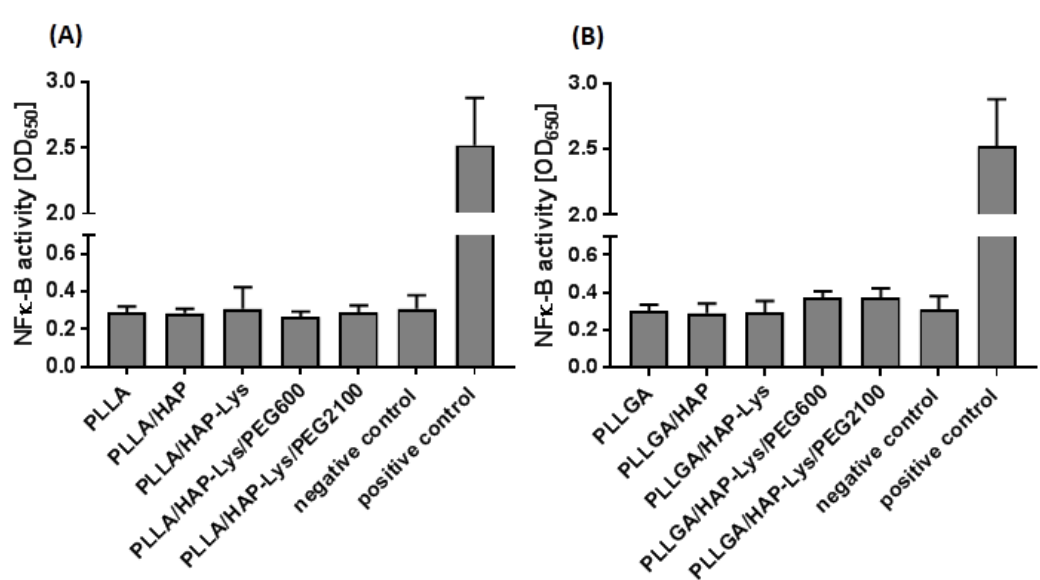
Figure 8. The activation of NF-κB transcription factor in THP1-Blue™ in monocytes incubated for 24 h with ( A ) PLLA- and ( B ) PLLGA-based composites in comparison with monocytes stimulated with lipopolysaccharide (LPS) of Escherichia coli (positive control) or cell culture medium (negative control). The secreted embryonic alkaline phosphatase release following toll-like receptor stimulation and NF-κB induction was quantified spectrophotometrically (OD = 650 nm) after enzymatic substrate conversion. Data are presented as mean ± SD of three separate experiments (six replicates of each assay).